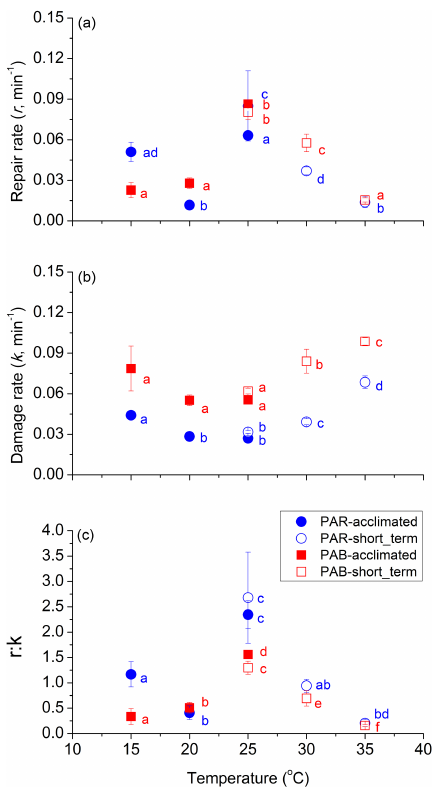
Figure 5. The repair rate (a) and damage rate (b) of photosys- tem II in Skeletonema sp. during PAR or PAB exposure under grown temperature (acclimated) or short-term elevated temperature (short_term), and the ratio of repair to damage rate (c) . Vertical lines in panel (a) and (b) represent SD, n = 3, while vertical lines in panel (c) represent variance. Data points with different lowercase letters (blue for PAR treatment, and red for PAB treatment) indicate sig- nificant differences among temperature treatments.